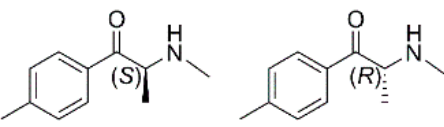
Figure 1. Structures of ( S )- and ( R )-mephedrone.